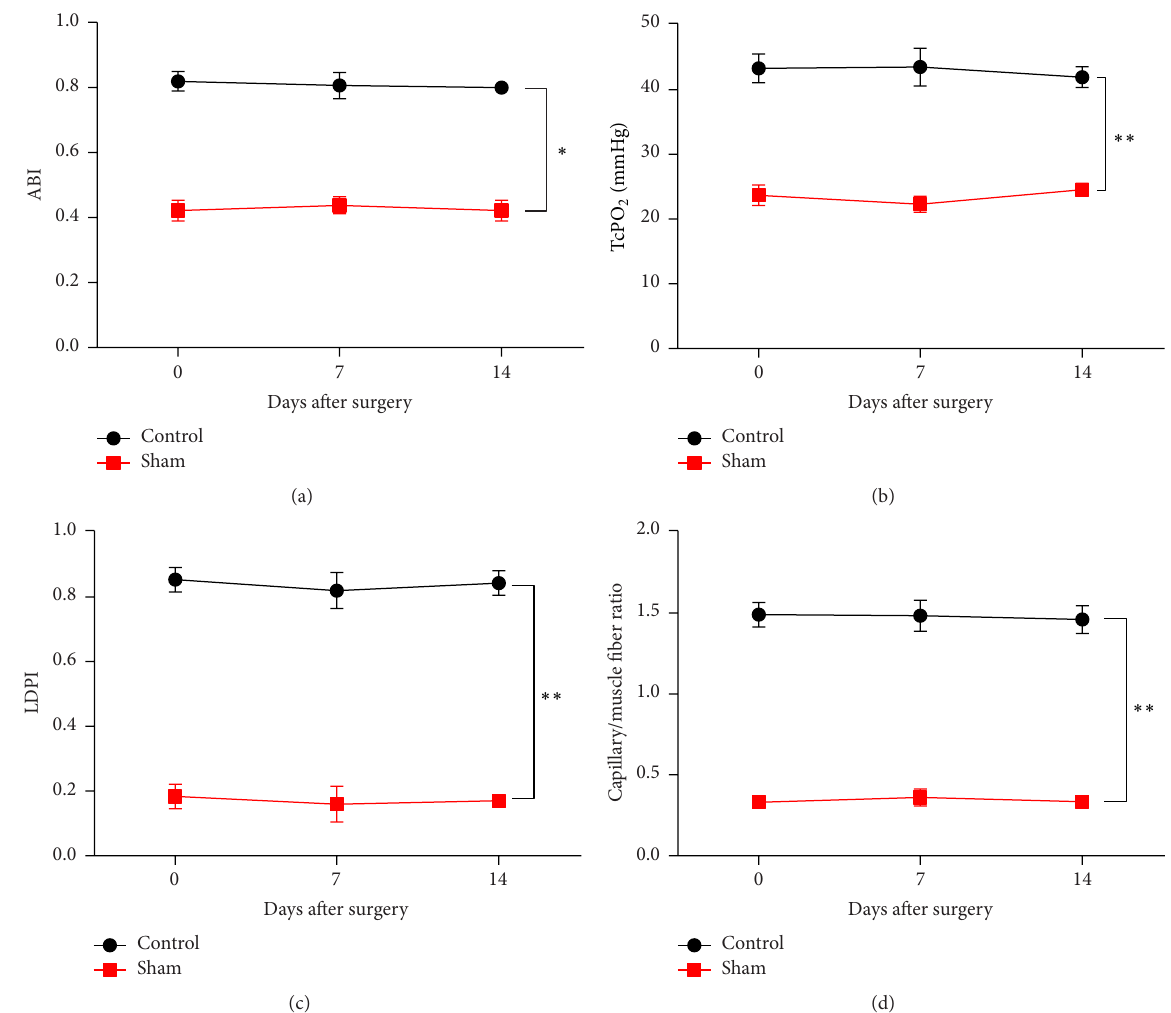
Figure 2: Evaluation of hindlimb ischemia model. (a) ABI, (b) TcPO 2 , (c) LDPI, and (d) capillary/muscle fiber ratio were all significantly decreased in the sham group compared with those in the control group. Data are presented as means ± SD from three independent experiments. ∗ represents 𝑝 < 0.05 and ∗∗ represents 𝑝 < 0.01